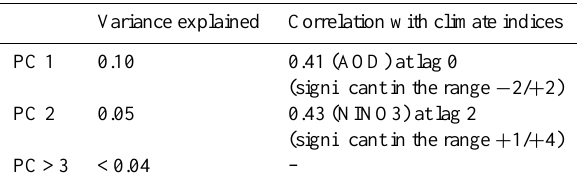
Table 4. Total rainfall variability decomposed through EOF anal- ysis. Each line displays the EOF explained variance (column 2) and the corresponding PC correlation with relevant climatic indices (column 3). Here the maximum PC correlation is reported consid- ering lagged correlations in the range − 16 to + 16. Only the corre- lation coefficients significant at the 1% level are